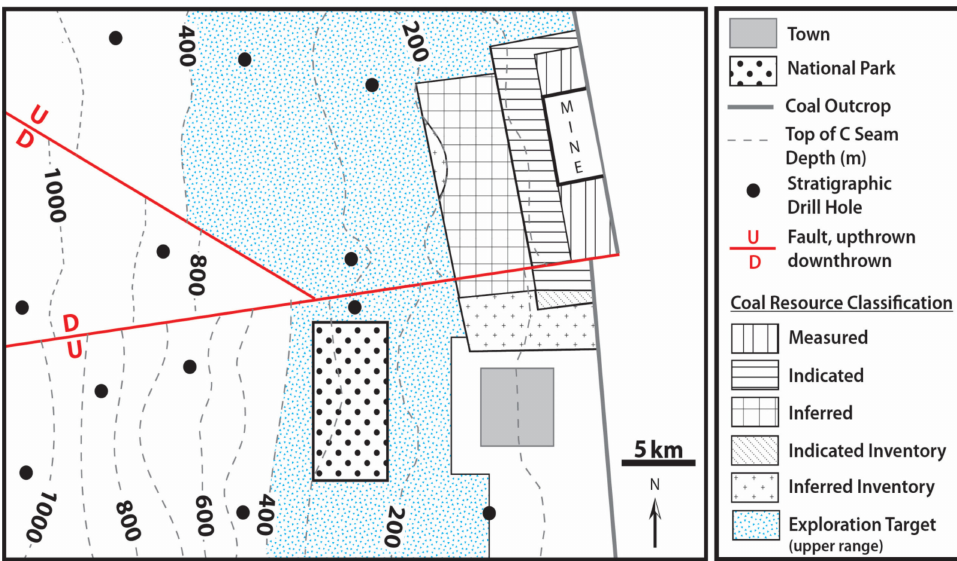
Figure 10. Hypothetical case study showing coal resource distribution. There is also an area of potentially surface mineable coal, in the north, where the upper range of thickness is 14 m (seams B and C) over an area of 35 km 2 , with an